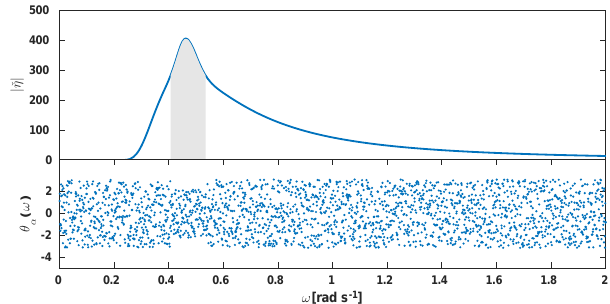
Figure 1. A Jonswap spectrum with restricted random phases, θ α (ω) . The shaded area represents the energy-carrying modes (re- stricted by a half standard deviation).